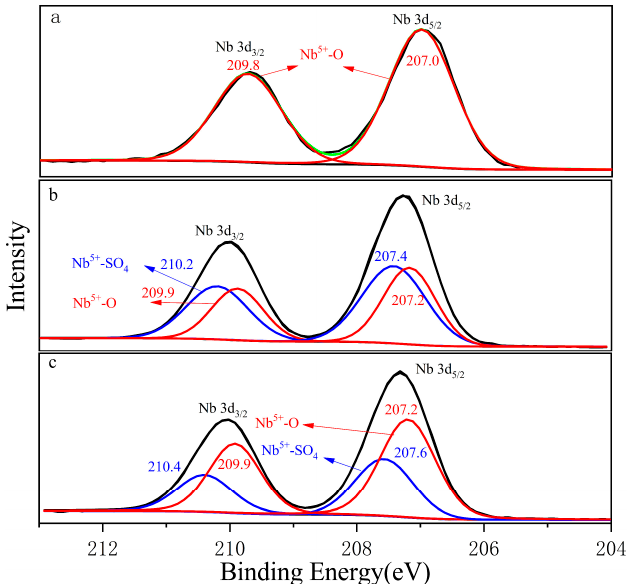
Figure 4. The photoelectron spectrum of Nb, ( a ) ferrocolumbite; ( b ) 8 M H 2 SO 4 leaching residue; ( c ) 12 M H 2 SO 4 leaching residue.